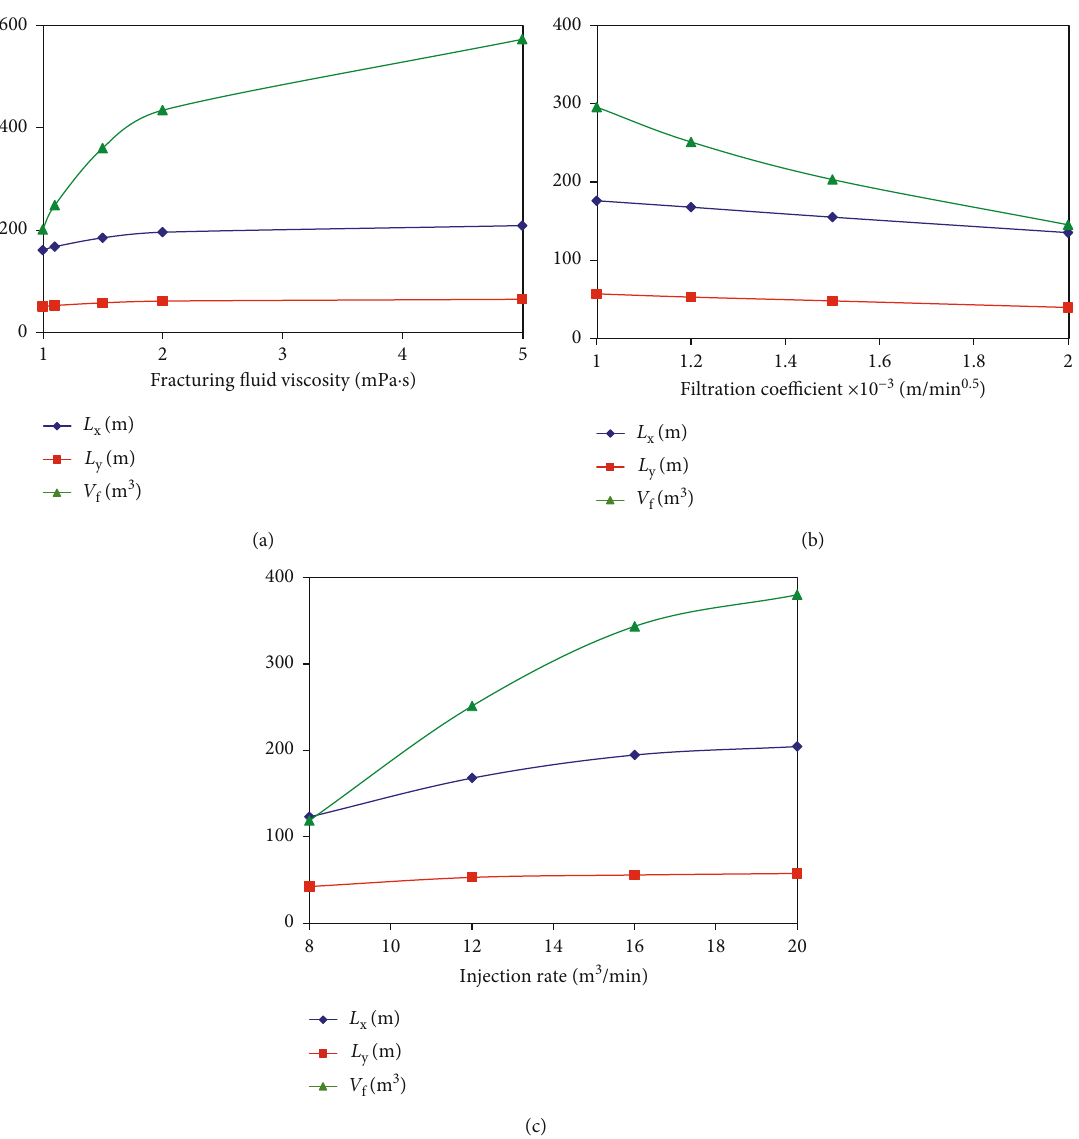
L V x , y , and f with fracturing